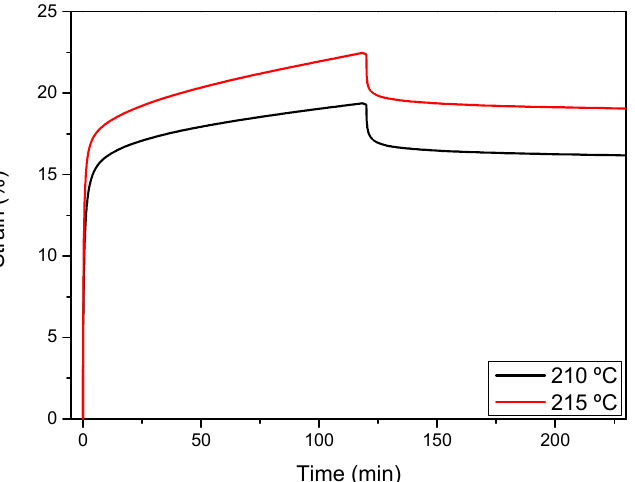
Figure 7. Creep experiments of reference RTM6 and aero grade epoxy vitrimer at temperatures below Tg (from Tg − 140 °C to Tg − 50 °C) with applied stress of 10 MPa for 25 min.